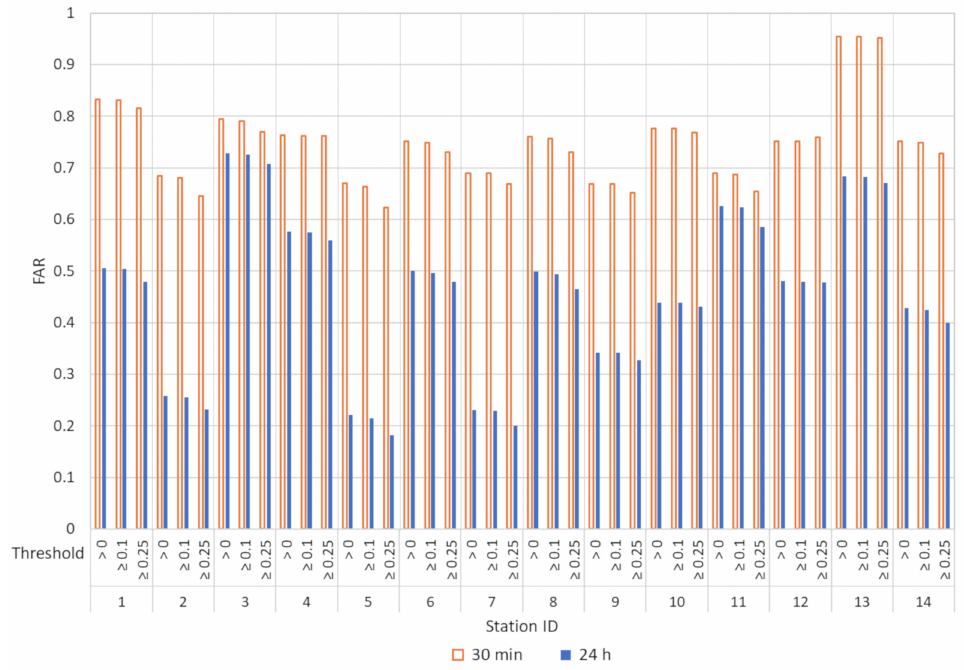
Figure 3. False alarm rate (FAR) results by station for di ff erent analyzed